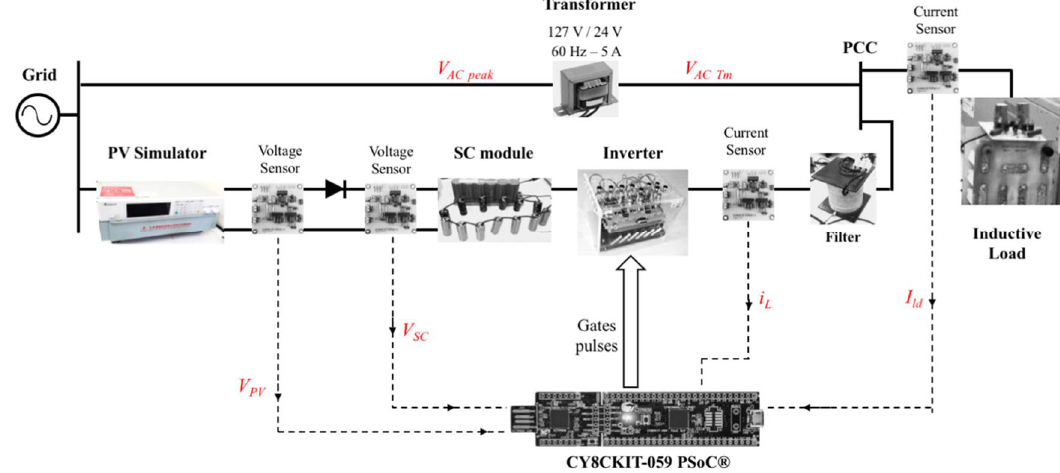
Figure 9. Experimental power system.